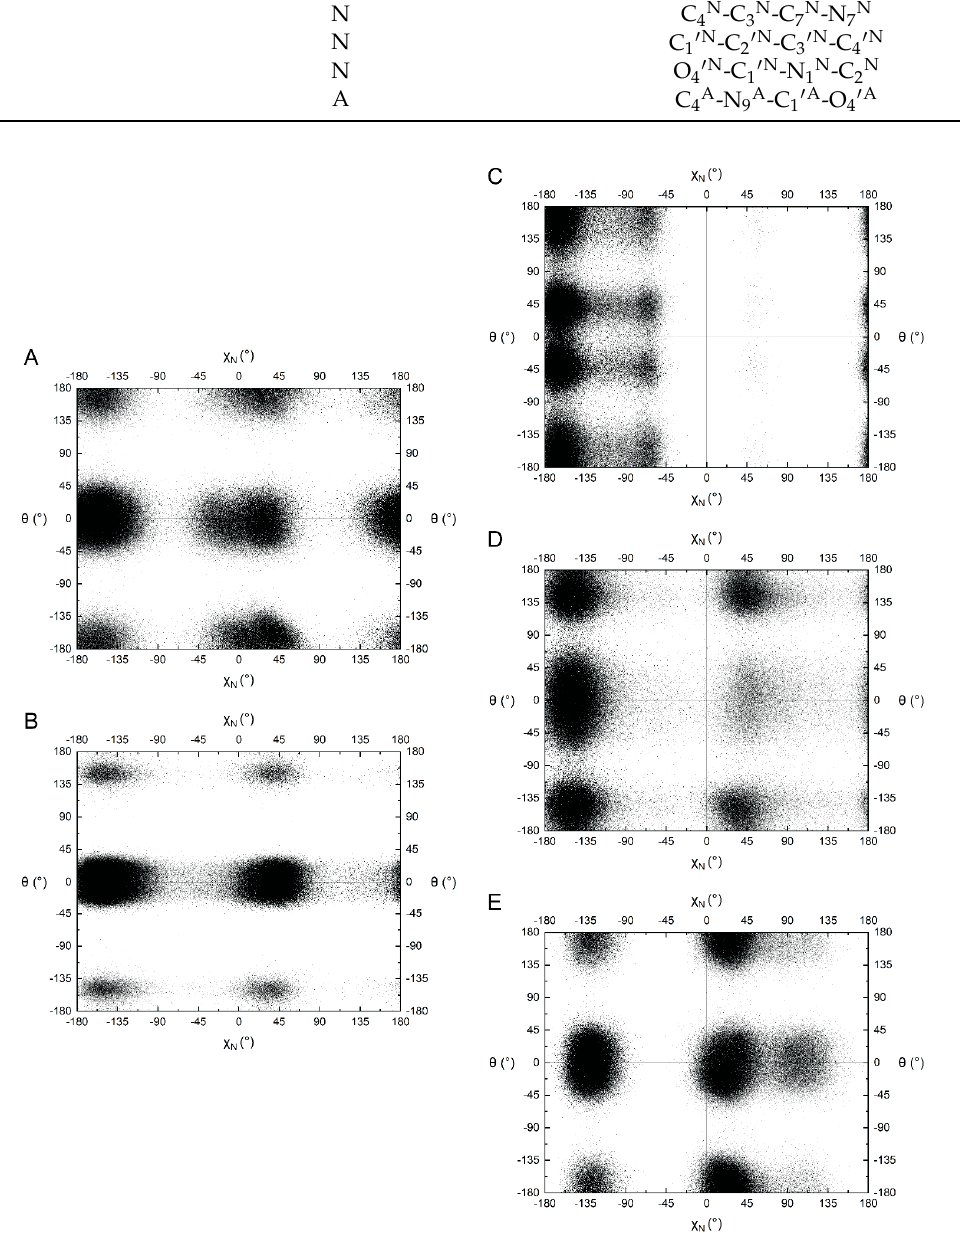
Figure 5. Scatter plot of the nicotinamide/pyridone amide dihedral angle ( θ ) versus nicotinamide glycosidic bond dihedral angle ( χ N ) for ( A ) NAD + , ( B ) NADH, ( C ) 2-ox-NAD, ( D ) 4-ox-NAD, and ( E ) 6-ox-NAD.